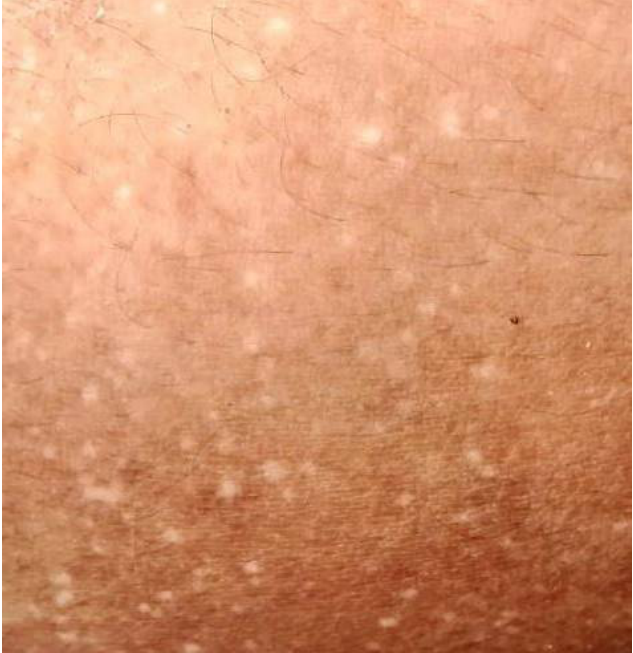
Figure 2. Close up photo of hypopigmented and hyperpigmented macules on the distal aspect of left arm.